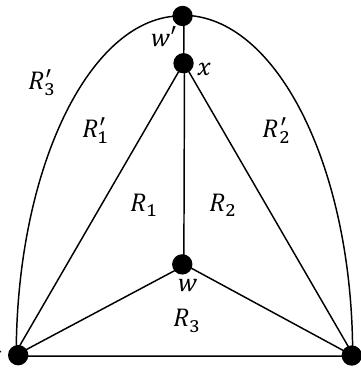
Figure 9: The structure of G which has w and w